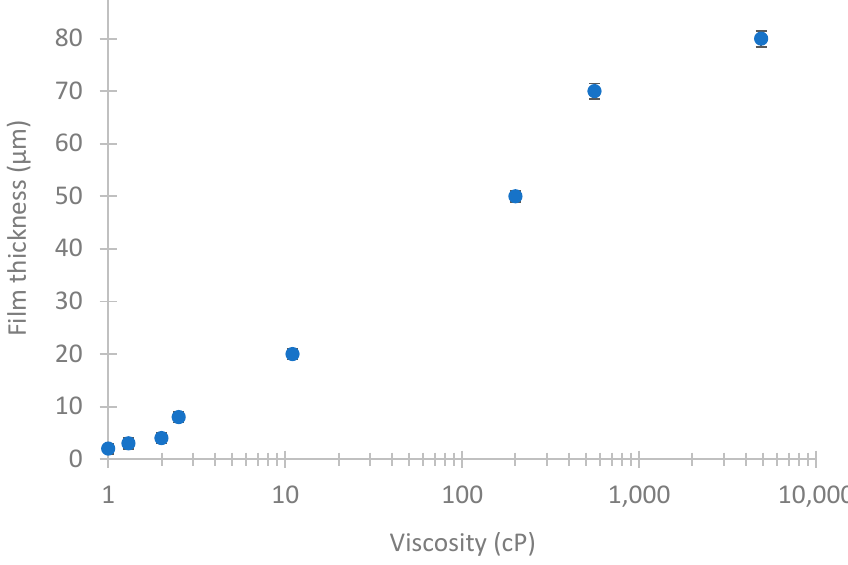
Figure 2. Influence of the viscosity of the PDMS polymer solution on the film thickness.